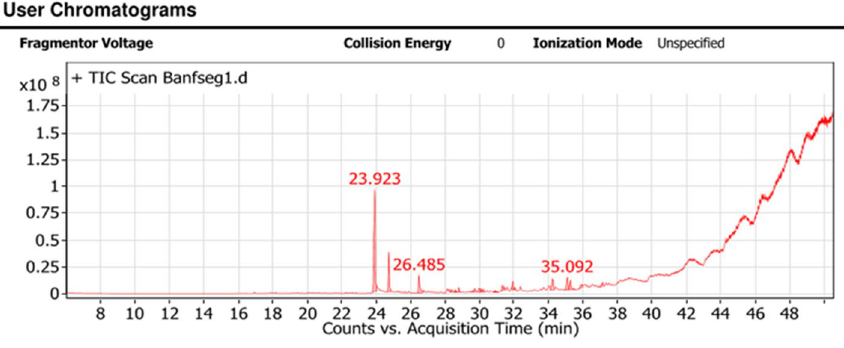
Figure 3. GC/MS analysis of the sample Viola odorata